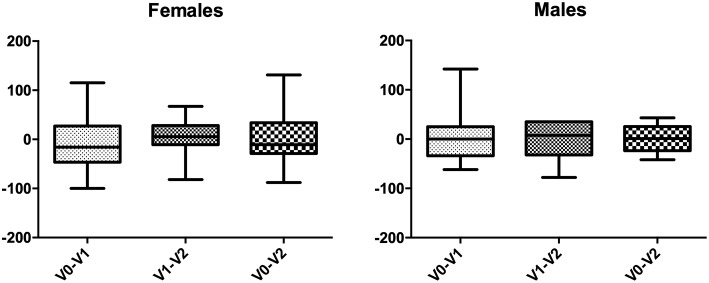
Graphical representation of IGF-1 variations in the two sexes.